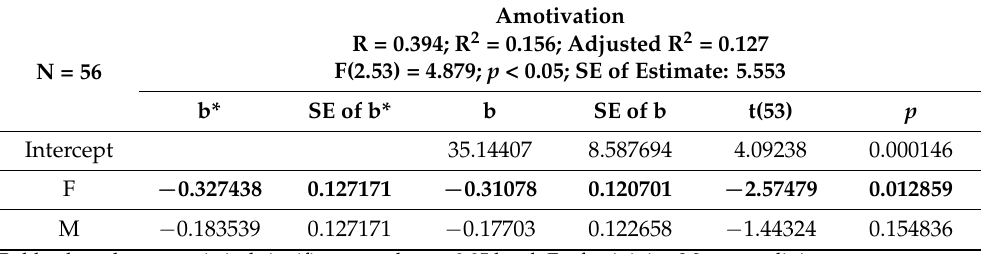
Table 7. Multiple regression explaining variation in amotivation based on psychological femininity and masculinity in the male study